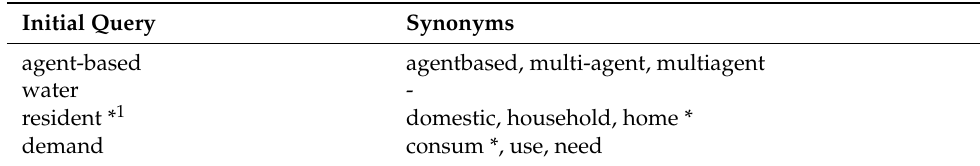
Table 2. Initial search queries and identified